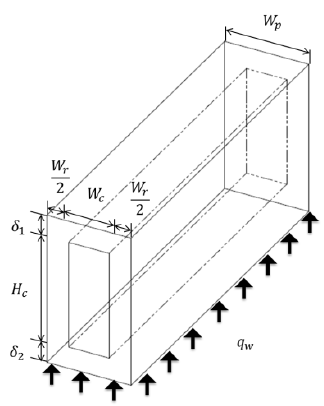
Figure 2. Symmetric unit of the micro multi ‐ channel heat sink.